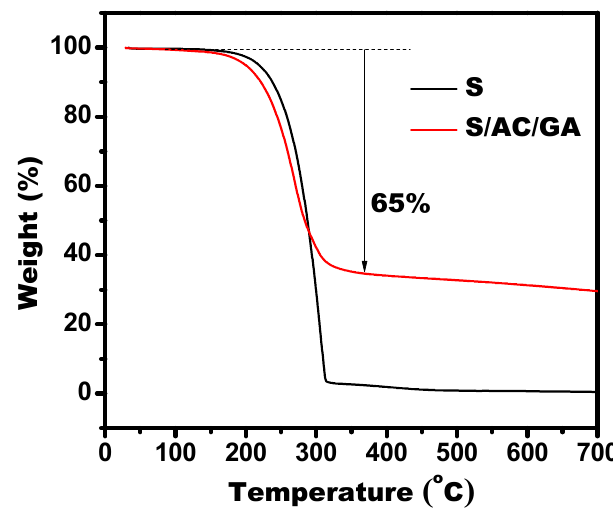
Figure 4. Thermogravimetric analysis (TGA) data of S/AC/GA composite.